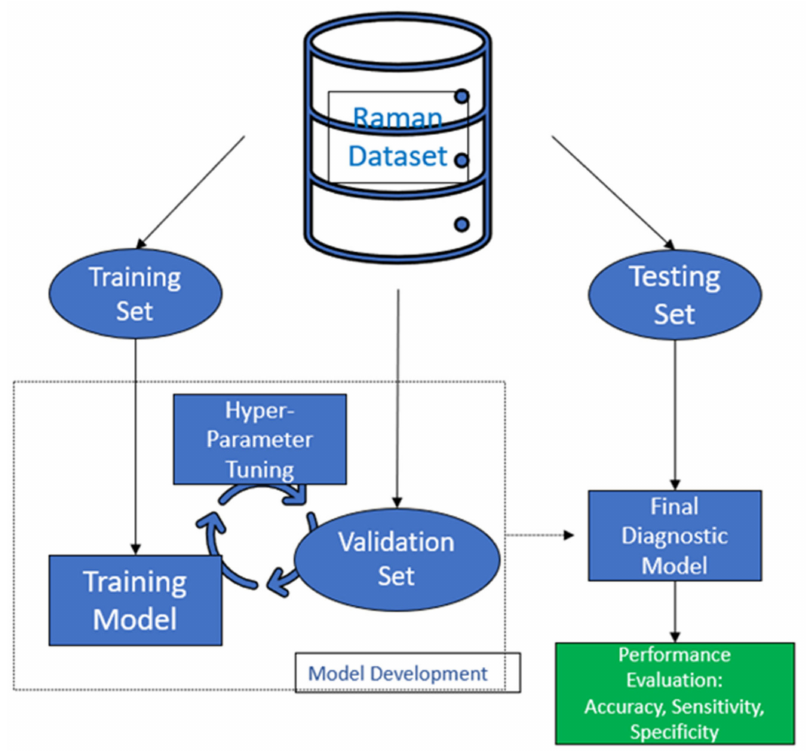
Figure 2. Depicts the basic structure of Machine Learning workflow applied on a Raman